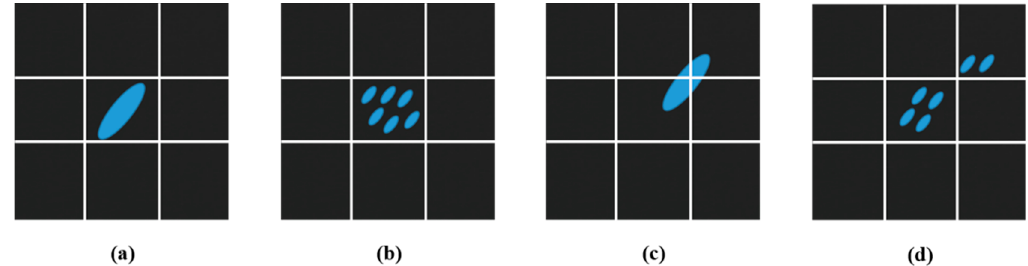
Figure 5. Structural and textural complexity analyses. ( a ) has a lower textural distribution ratio D and a simple structure; ( b ) has a low textural distribution ratio D and a complex structure; ( c ) has a more complex textural distribution ratio D and a simple structure; and ( d ) has a more complex textural distribution ratio D and a complex structure.